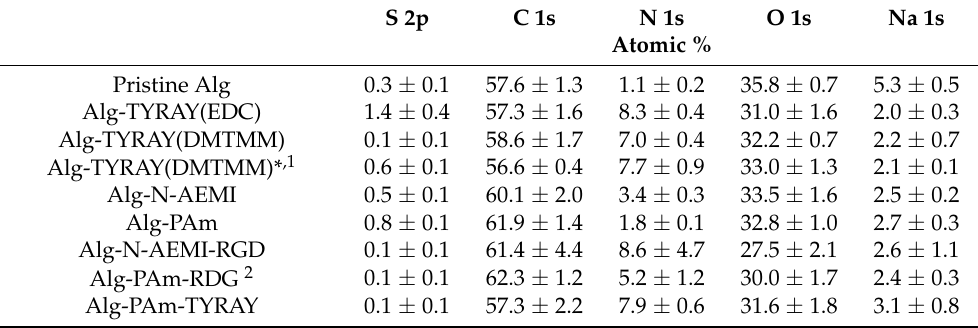
Table 1. Elemental composition of pristine and modified alginate determined via XPS